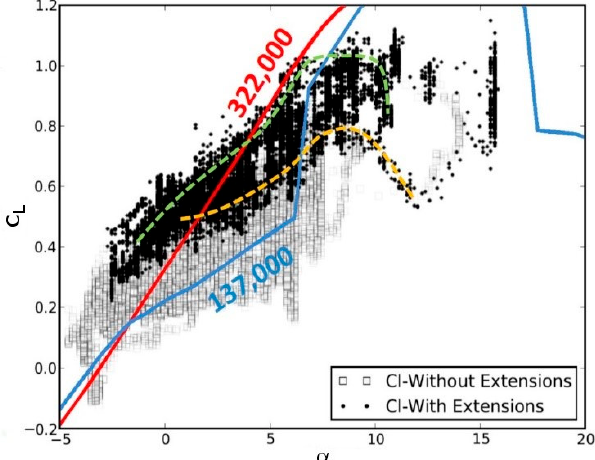
Figure 40. Lift coefficient data from flight tests (symbols; reprinted by permission of the American Institute of Aeronautics and Astronautics, Inc. (Reston, VA, USA) from [37]) superimposed with curve fits for minima and maxima with extensions and wind tunnel lift curves for Re = 137,000 and 322,000.